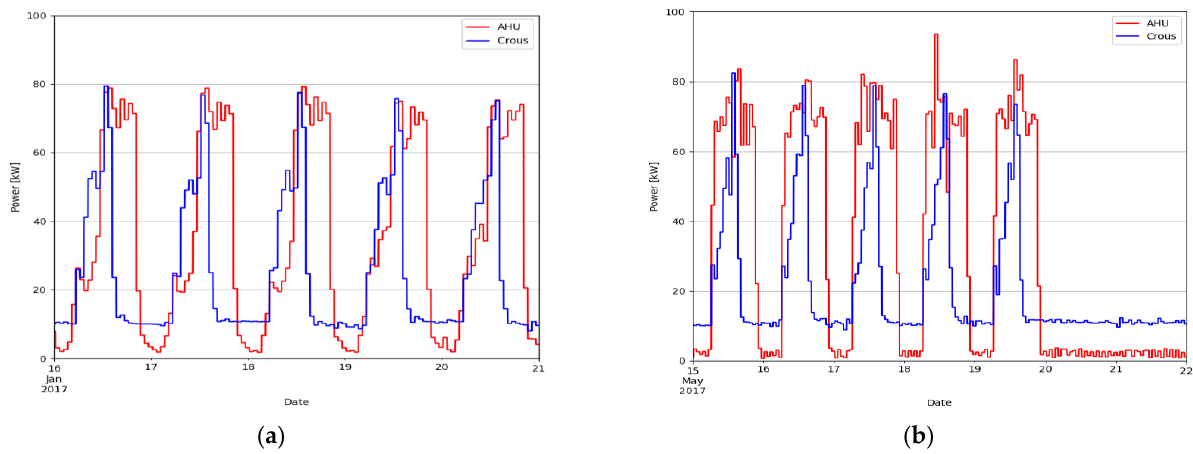
Figure 9. Power data for the Crous and AHU loads, ( a ) Training Period, ( b ) Test Period.